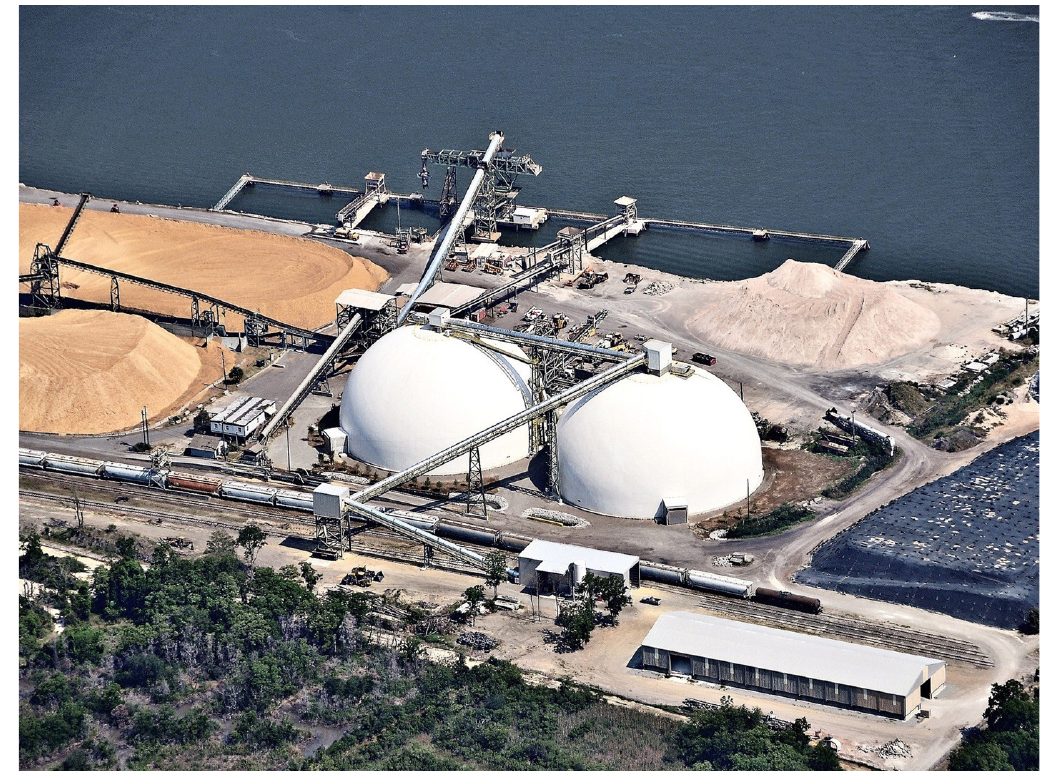
Figure 4. Peeples Industries—Wood Pellet bulk storage silos. Source: Dome Technology (2021).